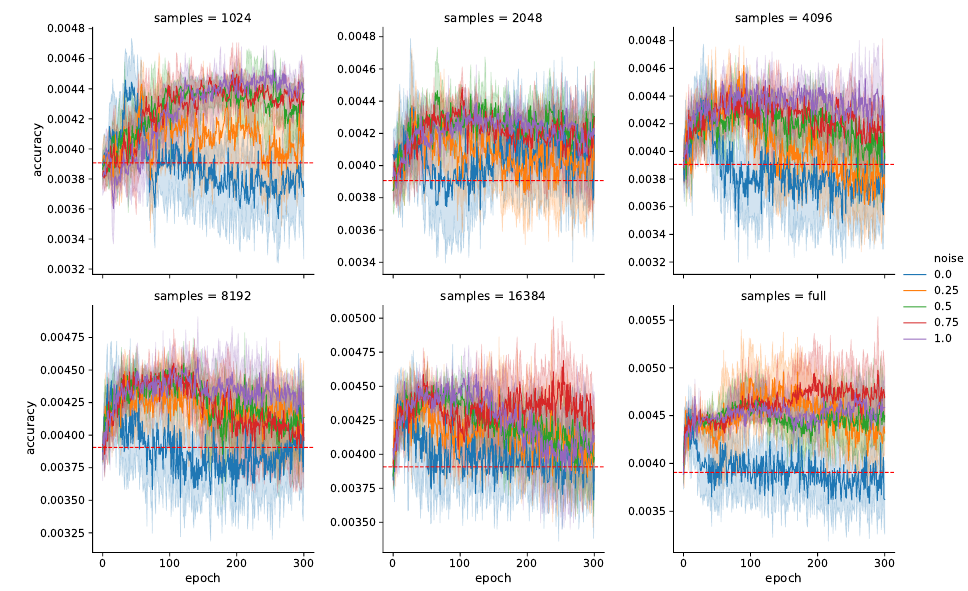
Figure 9: RD Network on AES_HD